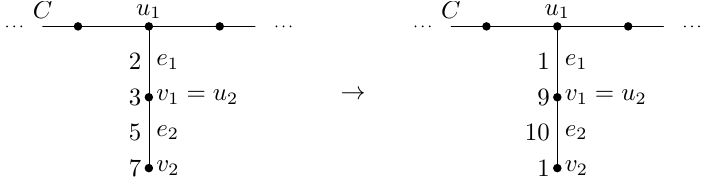
Figure 3: Recoloring of edges e